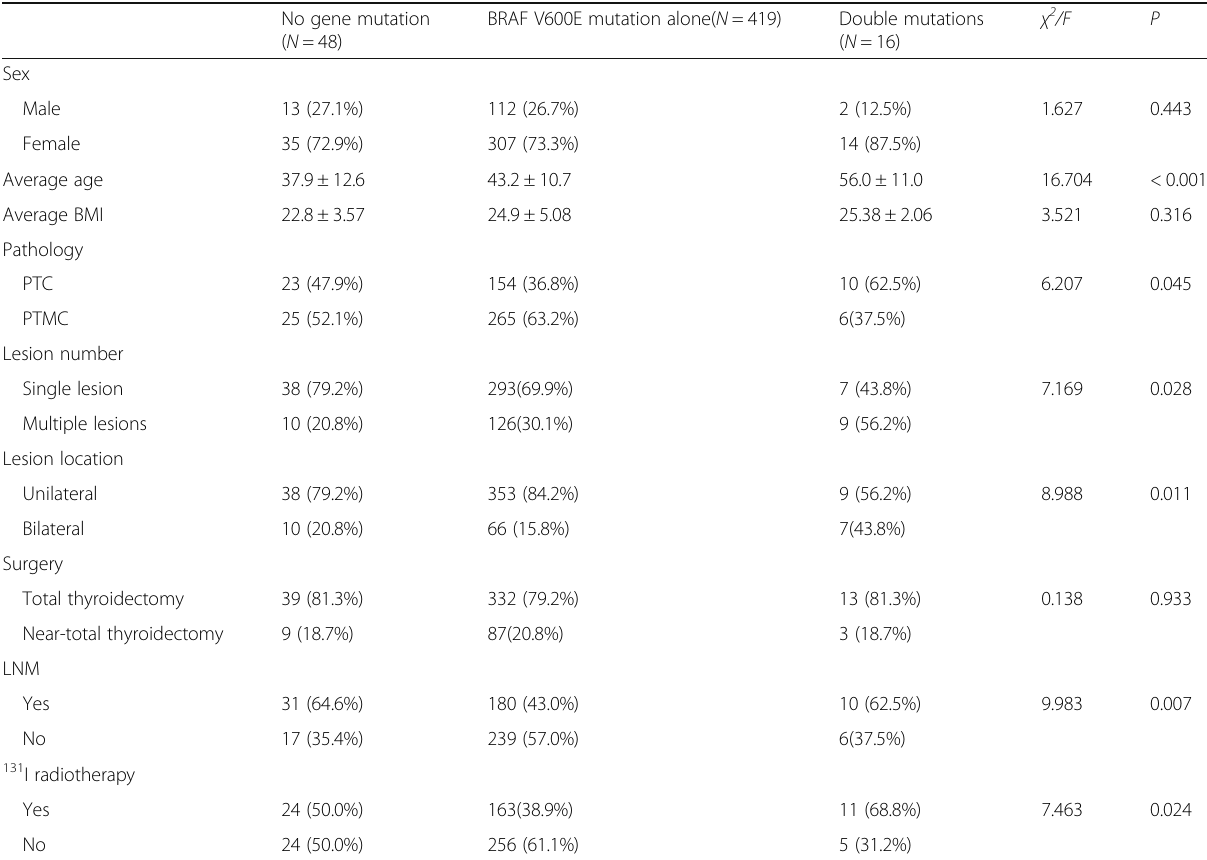
Table 3 Relationship between gene mutations and clinicopathologic features of PTC